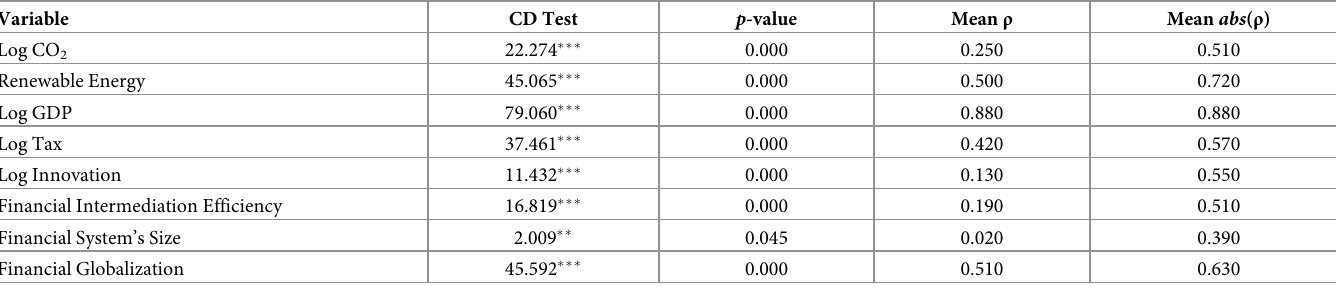
Table 2. Cross-sectional dependence test.